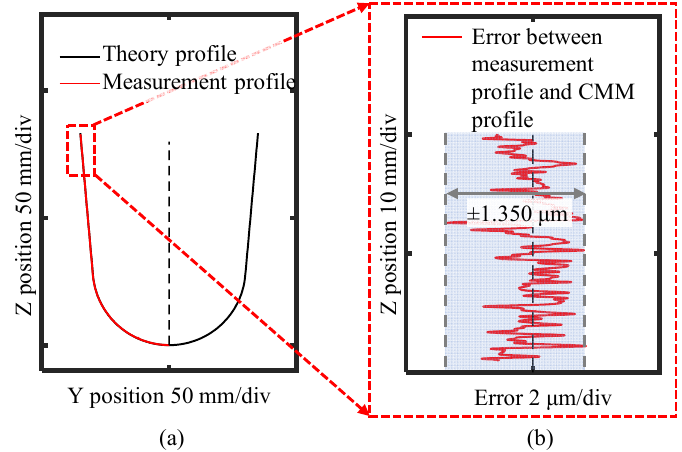
Figure 20. Measurement results of the inner profile of the high aspect ratio aspheric workpiece. ( a ) Comparison between theory profile and measurement profile; ( b ) measurement error of the high aspect ratio aspheric workpiece compared with the CMM measurement.